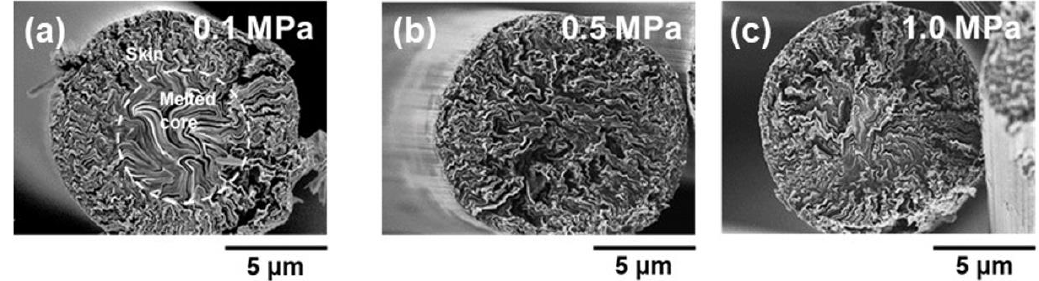
Figure 7. SEM images of the transverse sections of graphitized fibers stabilized under various air flow pressures: ( a ) 0.1 MPa, ( b ) 0.5 MPa, and ( c ) 1.0 MPa .